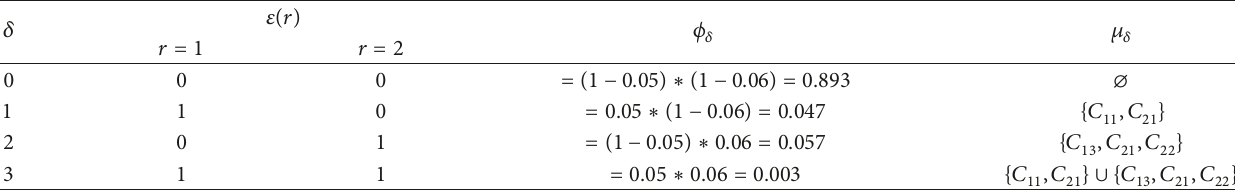
Table 2: Value of 𝜀(𝑟) , 𝜙 𝛿 , and 𝜇 𝛿 for any combination 𝛿